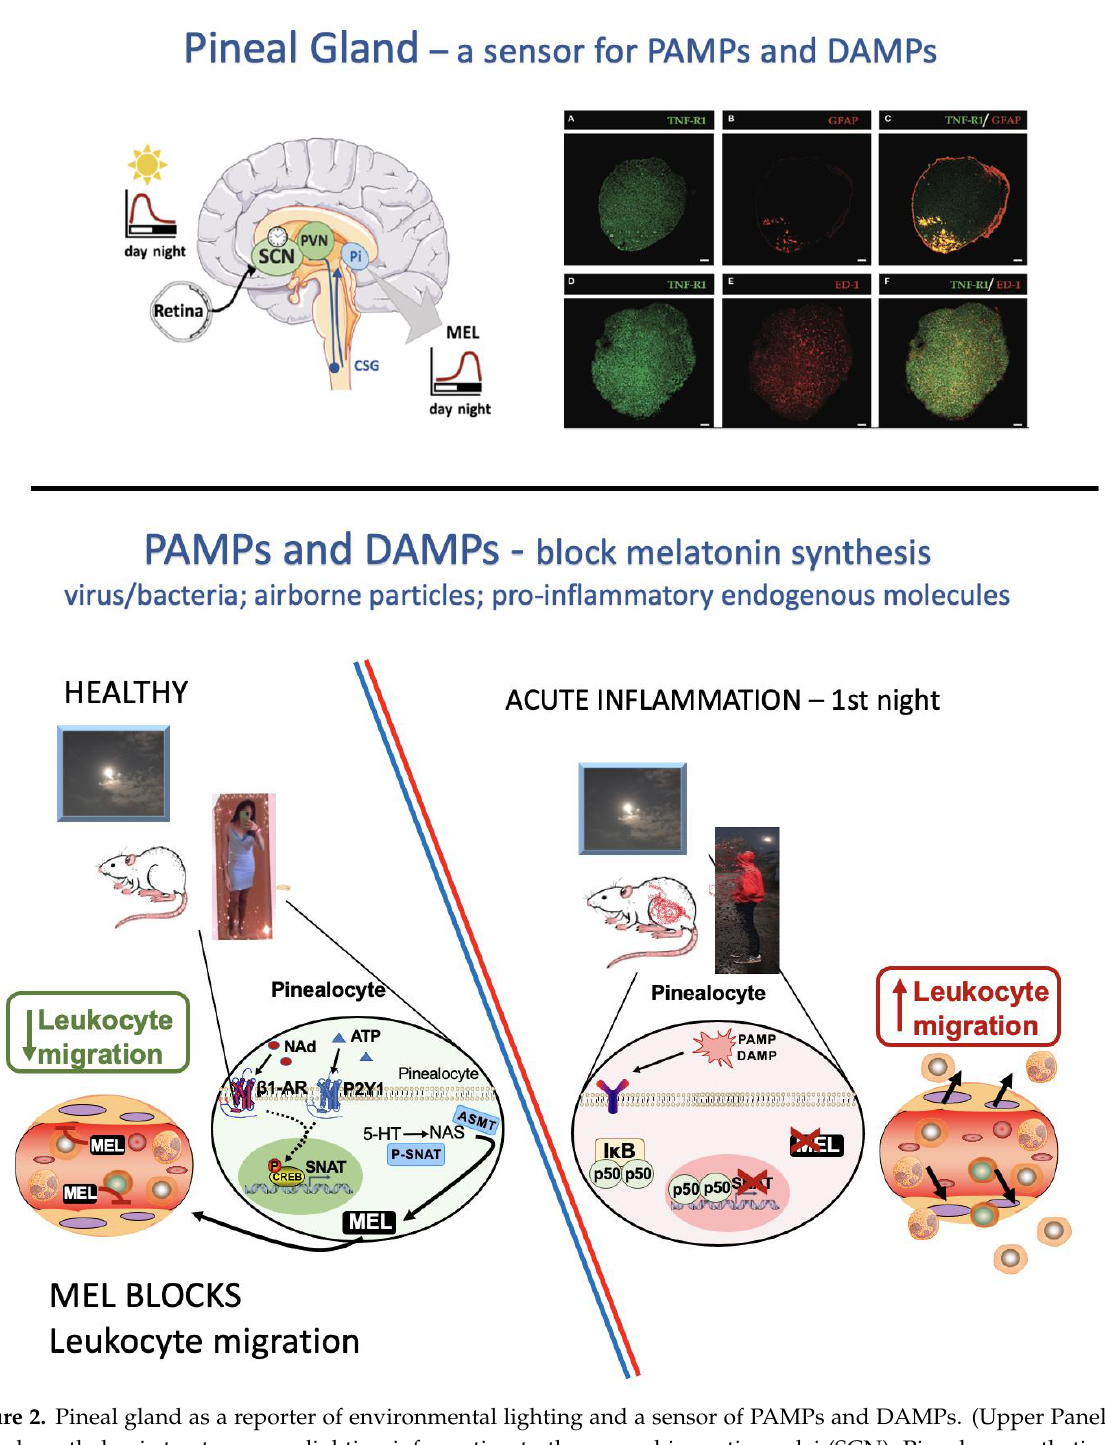
Figure 2. Pineal gland as a reporter of environmental lighting and a sensor of PAMPs and DAMPs. (Upper Panel) The retinohypothalamic tract conveys lighting information to the suprachiasmatic nuclei (SCN). Pineal sympathetic input driven by a polysynaptic pathway via the paraventricular nuclei (PVN) of the hypothalamus and the cervical superior ganglion (CSG) releases noradrenaline (NAd) and ATP. The pineal gland is composed of pinealocytes, astrocytes, and microglia. Astrocytes are localized around the blood vessels, and microglia are dispersed along the pinealocytes. The immunopositive labeling of TNF-R1 throughout the pineal parenchyma is shown in green. The astrocytes (GFAP-labeled, in red) are restricted to the proximal region near the pineal stalk, and most of them express TNFR1 (yellow). Microglia (ED-1-labeled, in red) co-localize with TNF-R1 and pinealocytes also express TNF-R1. Scale bar = 200 μm [16]. (Lower Panel) PAMPs and DAMPs block transcription of SNAT. Left side (healthy conditions): NAd acts on β-adrenoceptors, triggering the adenylyl cyclase/ cAMP/ protein kinase A (PKA) pathway. PKA phosphorylates CREB (cyclic AMP-related responsive element binding protein), which binds to CRE sequences in the Snat (serotonin N-acetyltransferase) promoter, inducing the gene’s transcription. The synthesized protein SNAT is activated by PKA phosphorylation. ATP triggers P2Y1